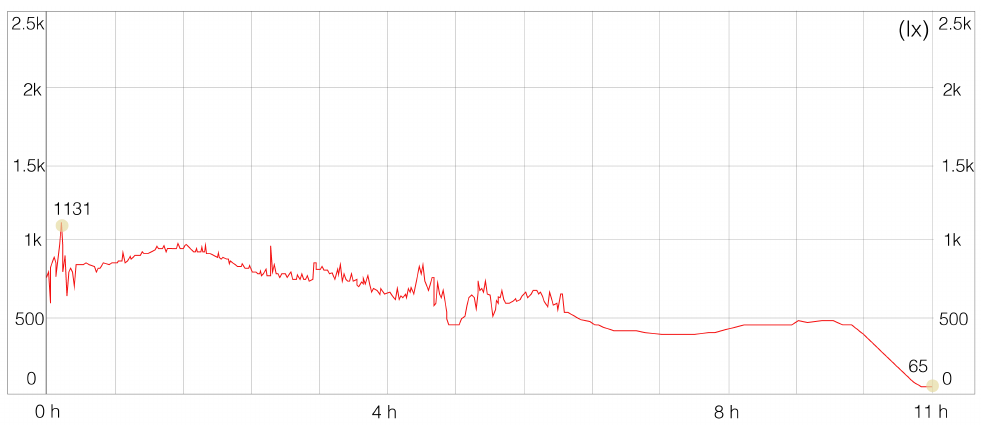
Figure 16. Testing the actual situation (before installing the kinetic façade).